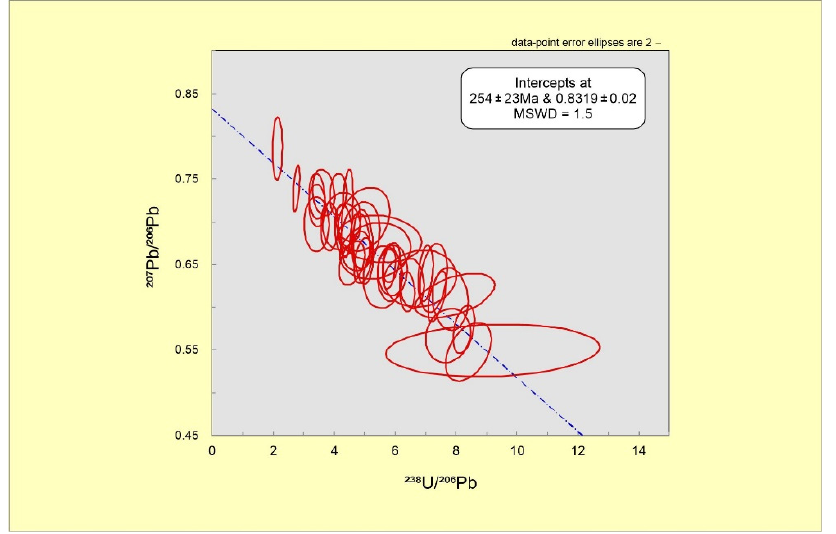
Figure 15. The LA ICP MS analysis of apatites from the Nižná Boca locality; sample M-8.